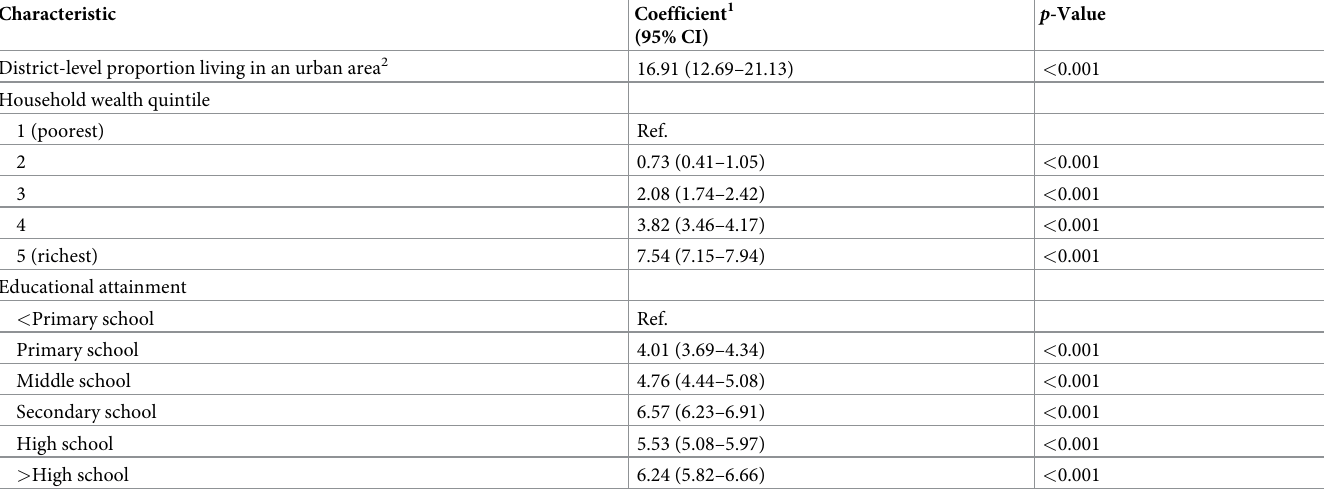
Table 4. Multivariable linear regression of the natural logarithm of 10-year cardiovascular disease risk on the proportion of participants in a district who live in an urban area.